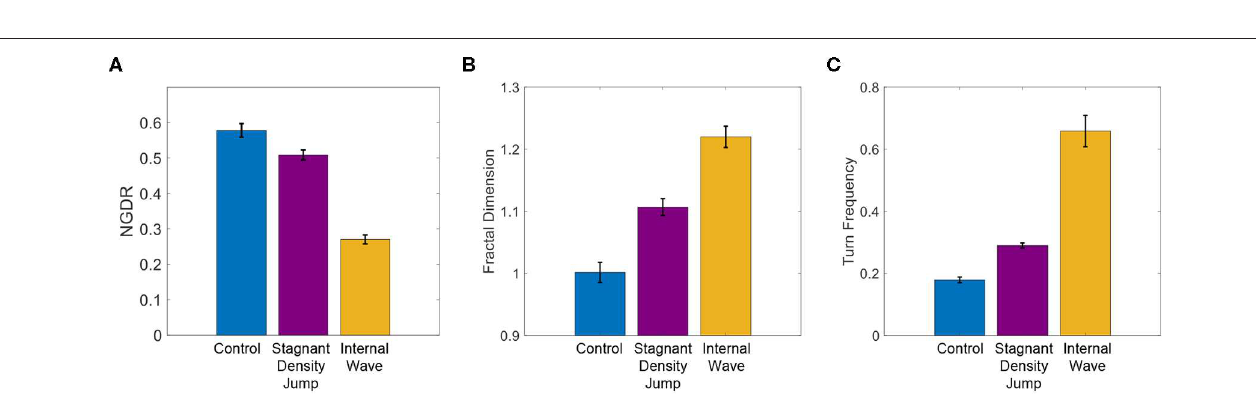
FIGURE 8 | (A) Copepod trajectories for the internal wave treatment with a density jump of 1.0 σ t . The black dashed lines indicate the boundaries of the internal wave. Color indicates the passage of time with blue corresponding to the beginning of the trajectory and red corresponding to the end. Although shown on the same plot, these trajectories were not collected simultaneously. (B) Probability Distribution Function (PDF) of copepod position in the vertical direction for the internal wave treatment with a density jump of 1.0 σ t .